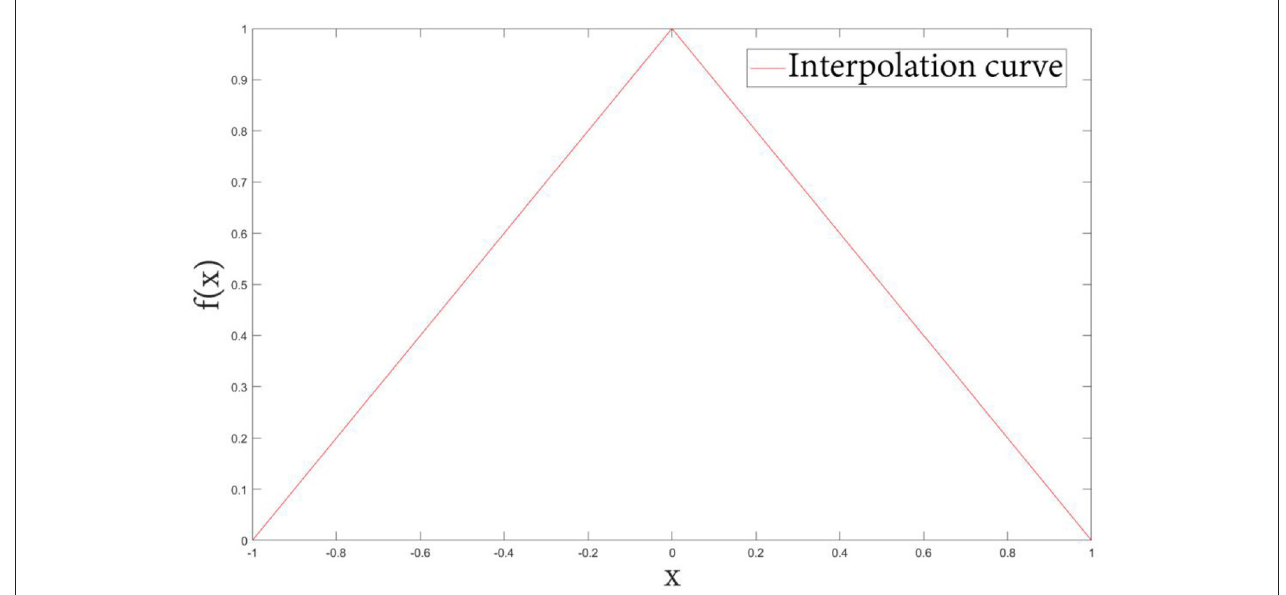
FIGURE 2 | Basic kernel curve.